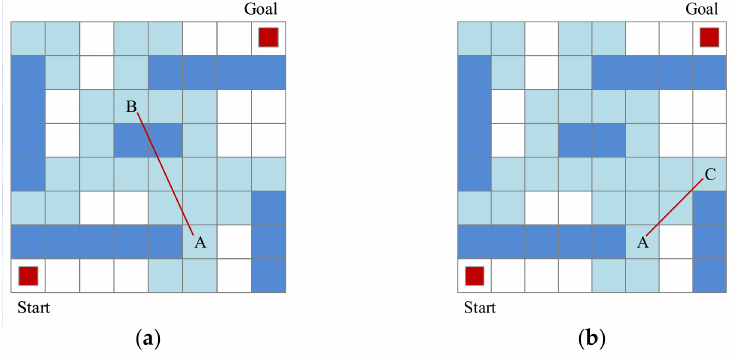
Figure 6. Connecting free cells to enable a path. ( a ) Unlinked cells; ( b ) linked cells.